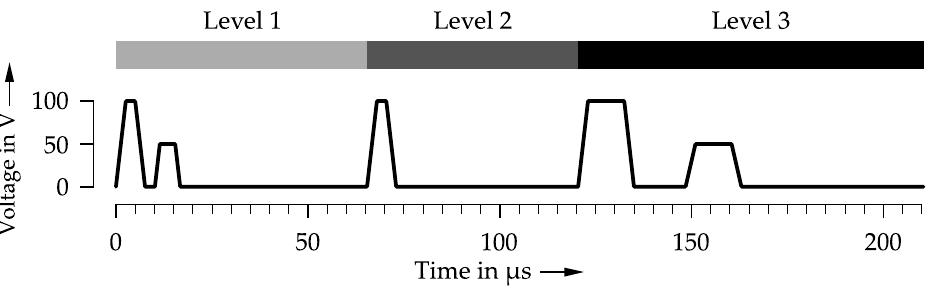
Figure 5. Piezo crystal control waveform to create three different droplet sizes for the Dimatix StarFire print head. Level 1 (light gray), level 2 (dark gray), level 3